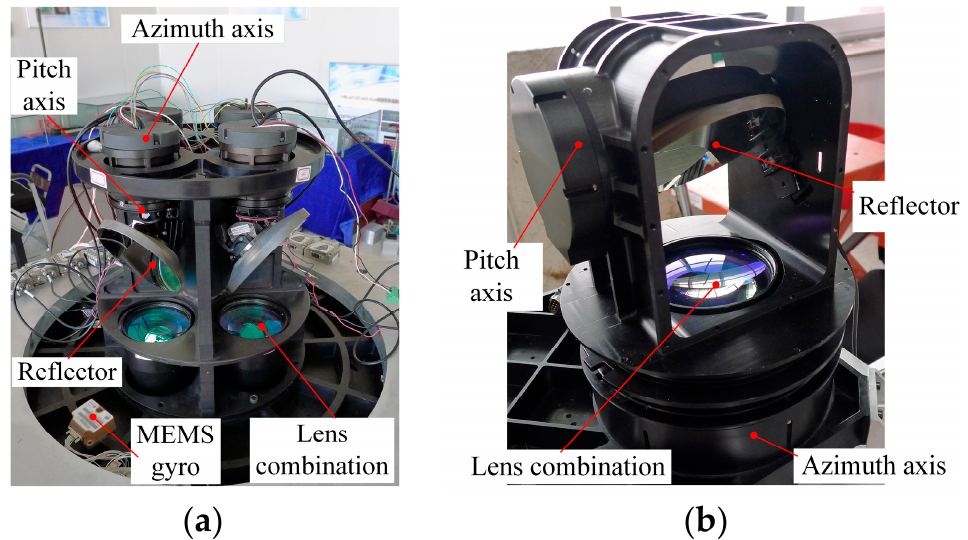
Figure 3. Transceivers for indoor laser communication networking. ( a ) The master optical transceiver; ( b ) The slave optical transceivers.